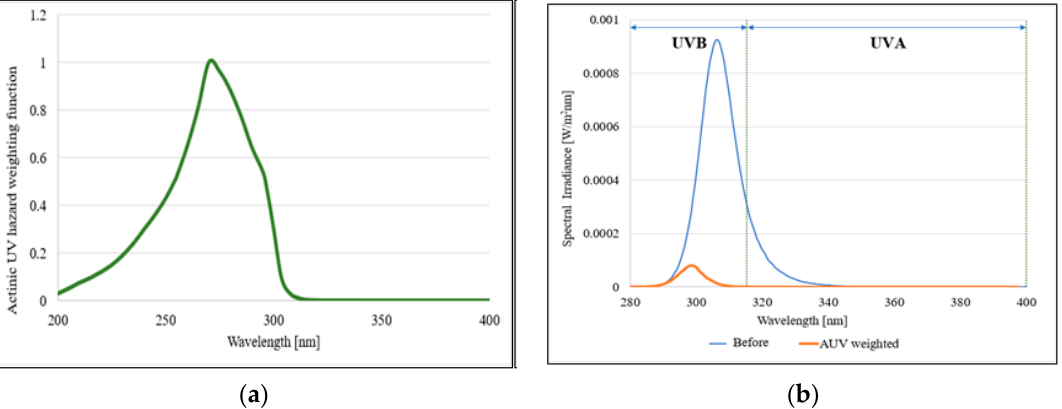
Figure 7. Spectral distribution of the proposed lighting (UV) and actinic hazard weighting function. ( a ) Weighting function of an actinic hazard; ( b ) Before and after applying the proposed lighting and the actinic hazard weighting function. Table 5. Comparison of the IEC 62471 standard and UV general lighting measurement results.